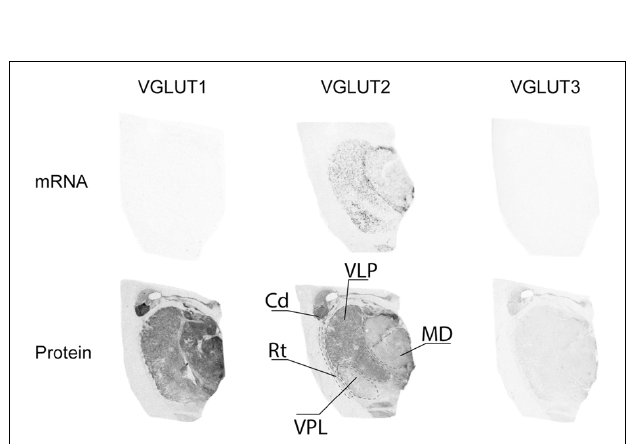
FIGURE 8 | Distribution of VGLUT1-3 mRNA and protein in the thalamus. Abbreviations: Cd, caudate nucleus; MD, mediodorsal thalamic nucleus; Rt, reticular thalamic nucleus; VLP, ventral lateral posterior thalamic nucleus; VPL, ventral posterior thalamic nucleus.